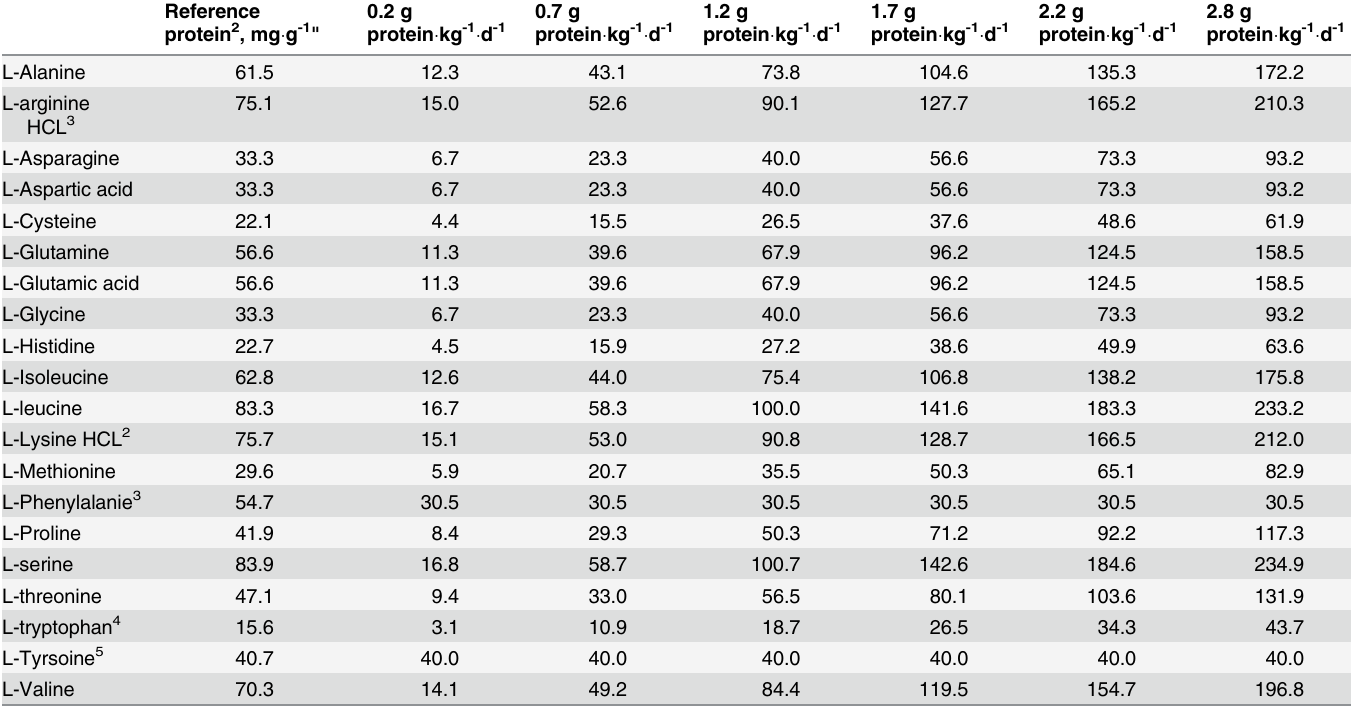
Table 2. Amino acid composition of reference protein and selected test protein intakes 1 . Reference protein 2 , mg (cid:1) g -1